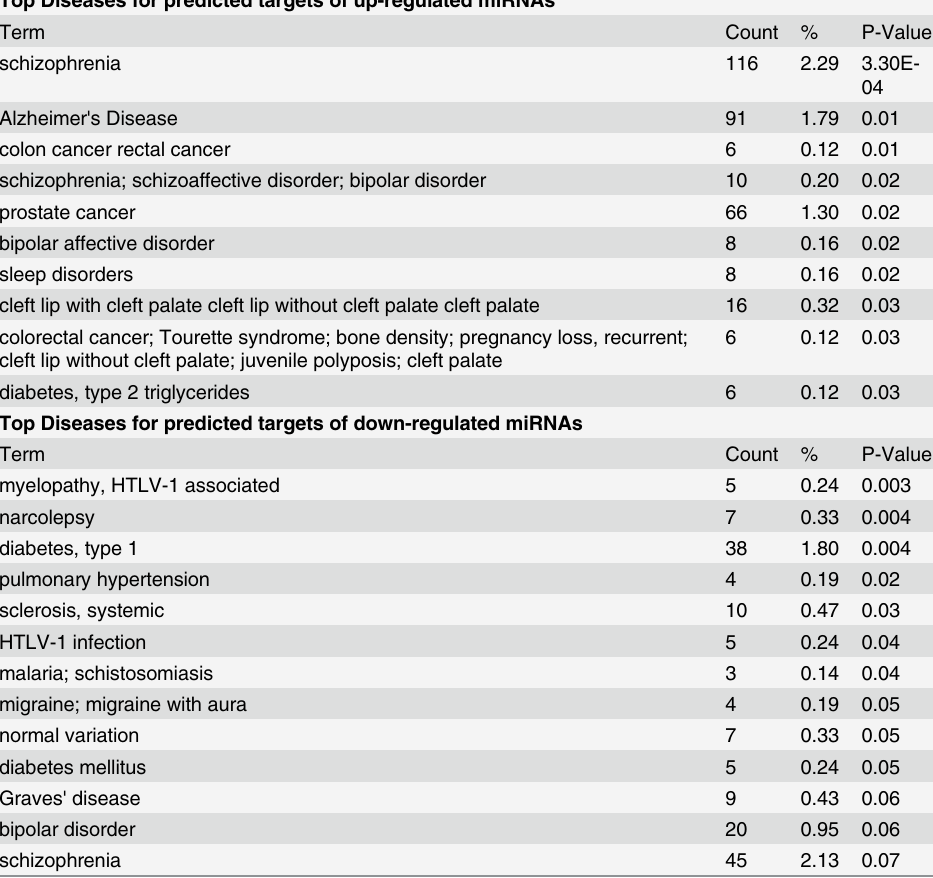
Table 4. DAVID functional annotation; Top Diseases for predicted targets of differentially expressed